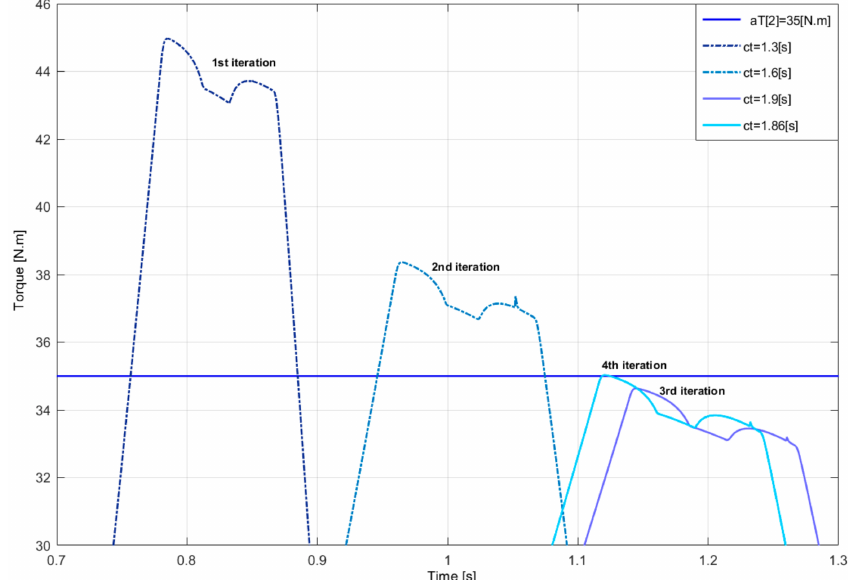
Figure 20. Di ff erent iterations of the cycle time minimization algorithm for improved path around the searched cycle time sct = 1